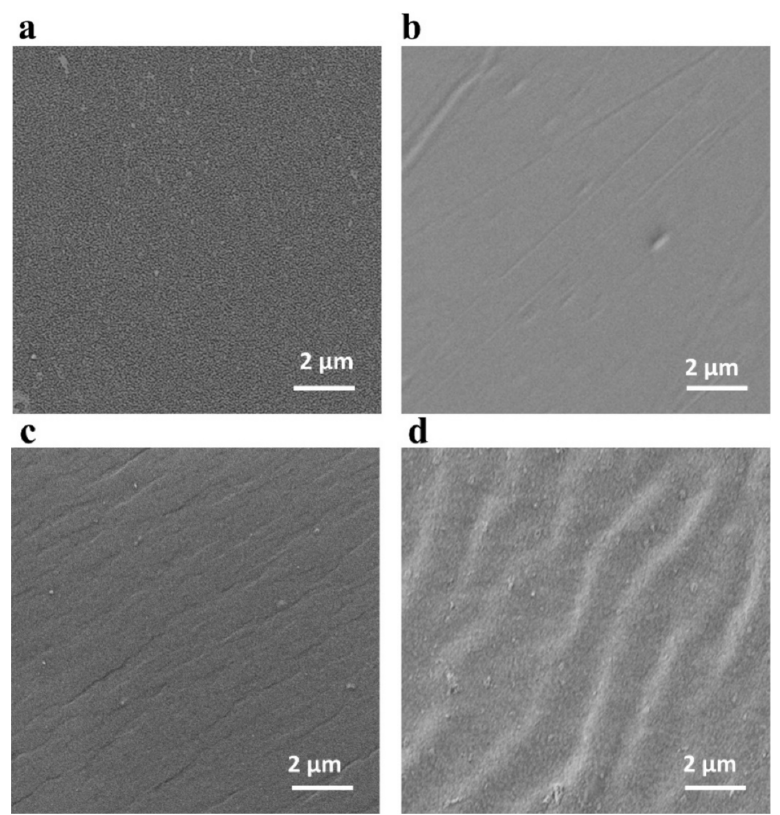
Figure 3. SEM surface images of PVC ( a ), P4VP ( b ), PVC-P4VP ( c ) and PVC-P4VP/PA membranes ( d ).